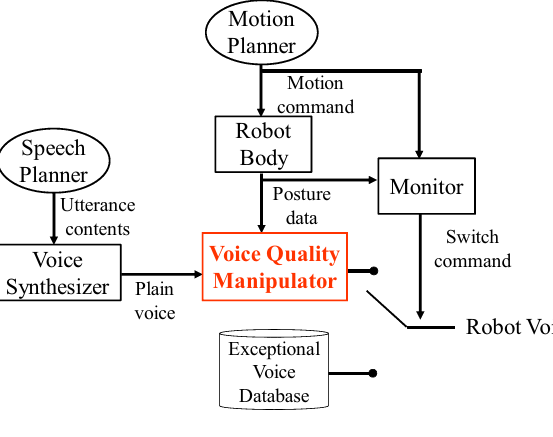
Figure 1. Voice-awareness